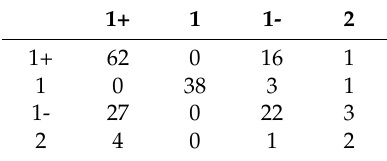
Table 8. Confusion-Matrix of tree vitality classification by ALS data.